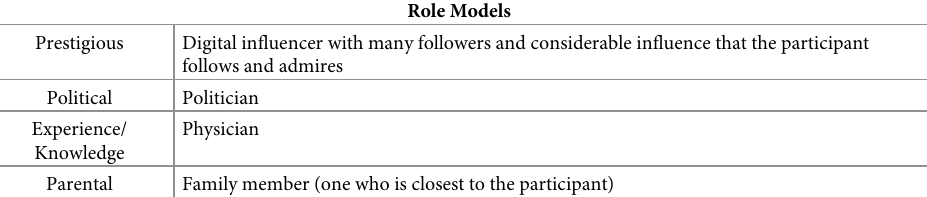
Table 1. Models used in the elaboration of the text to carry out the recall experiments and transmission of infor- mation about